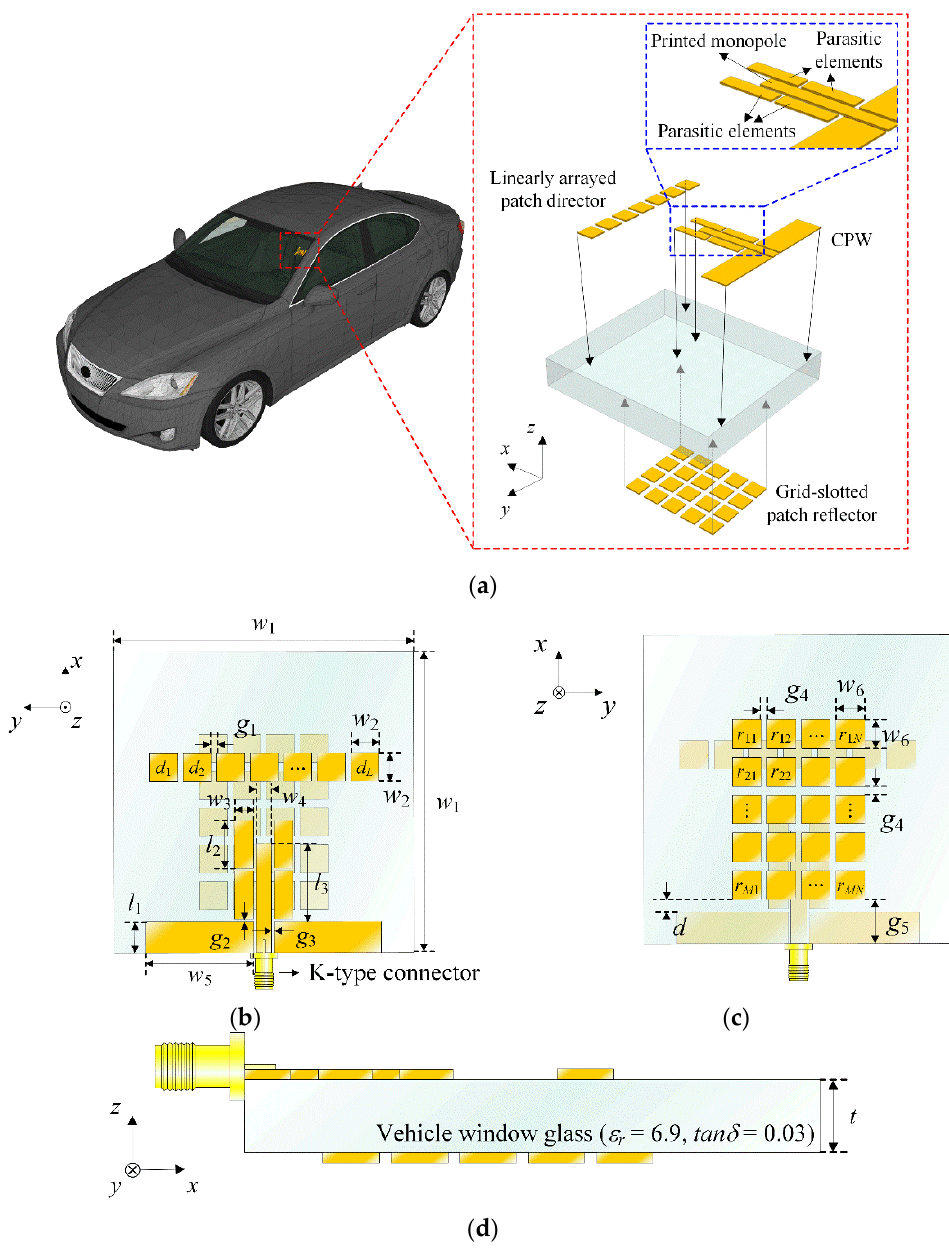
Figure 1. Geometry of the proposed antenna: ( a ) isometric view; ( b ) top view; ( c ) bottom view; ( d ) side view. Table 1. Design parameters of the proposed antenna.